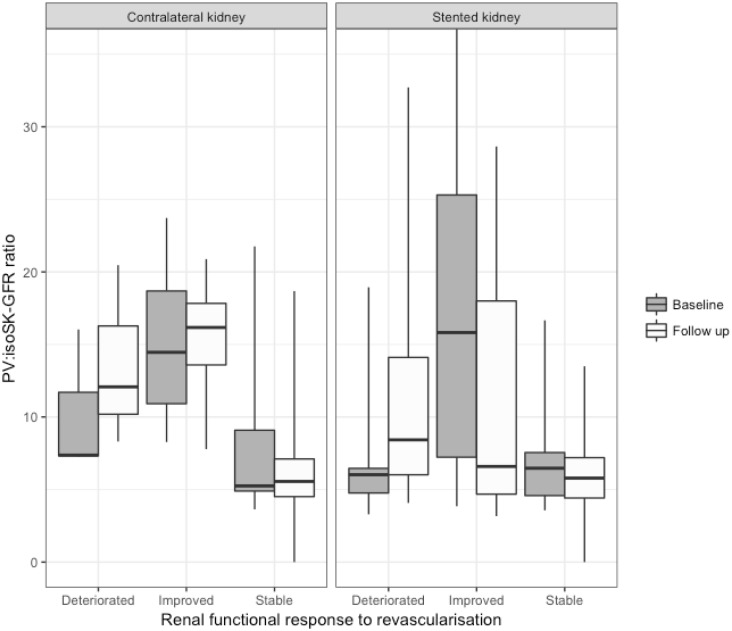
Box plot showing baseline (grey) and follow up (white) PV:isoSK-GFR characteristics in improver, stable and deteriorator kidneys.*P<0.05 within group.